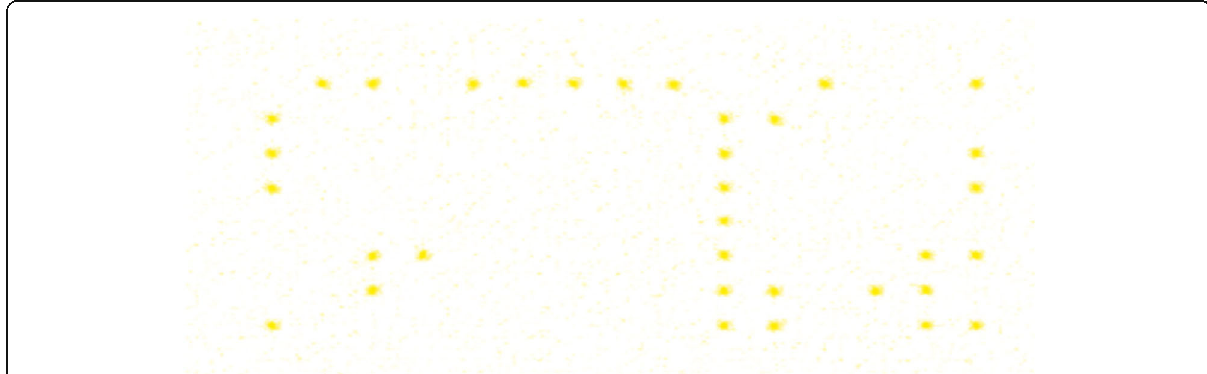
Fig. 8 The CMYK mode of the coded dots matrix embedded in a color laser printout of Xerox®